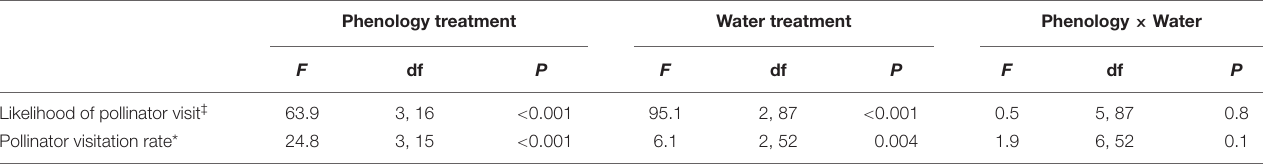
TABLE 2 | Results from analyses testing the effects of experimental variation in phenology and water treatments on the likelihood that a plant received a pollinator visit and the pollinator visitation rate to plants that received at least one visit, calculated as (total number of flowers visited/number of flowers available per hour of observation) averaged across the phenology